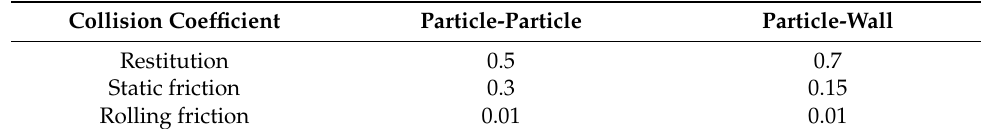
Table 3. Collison configurations.